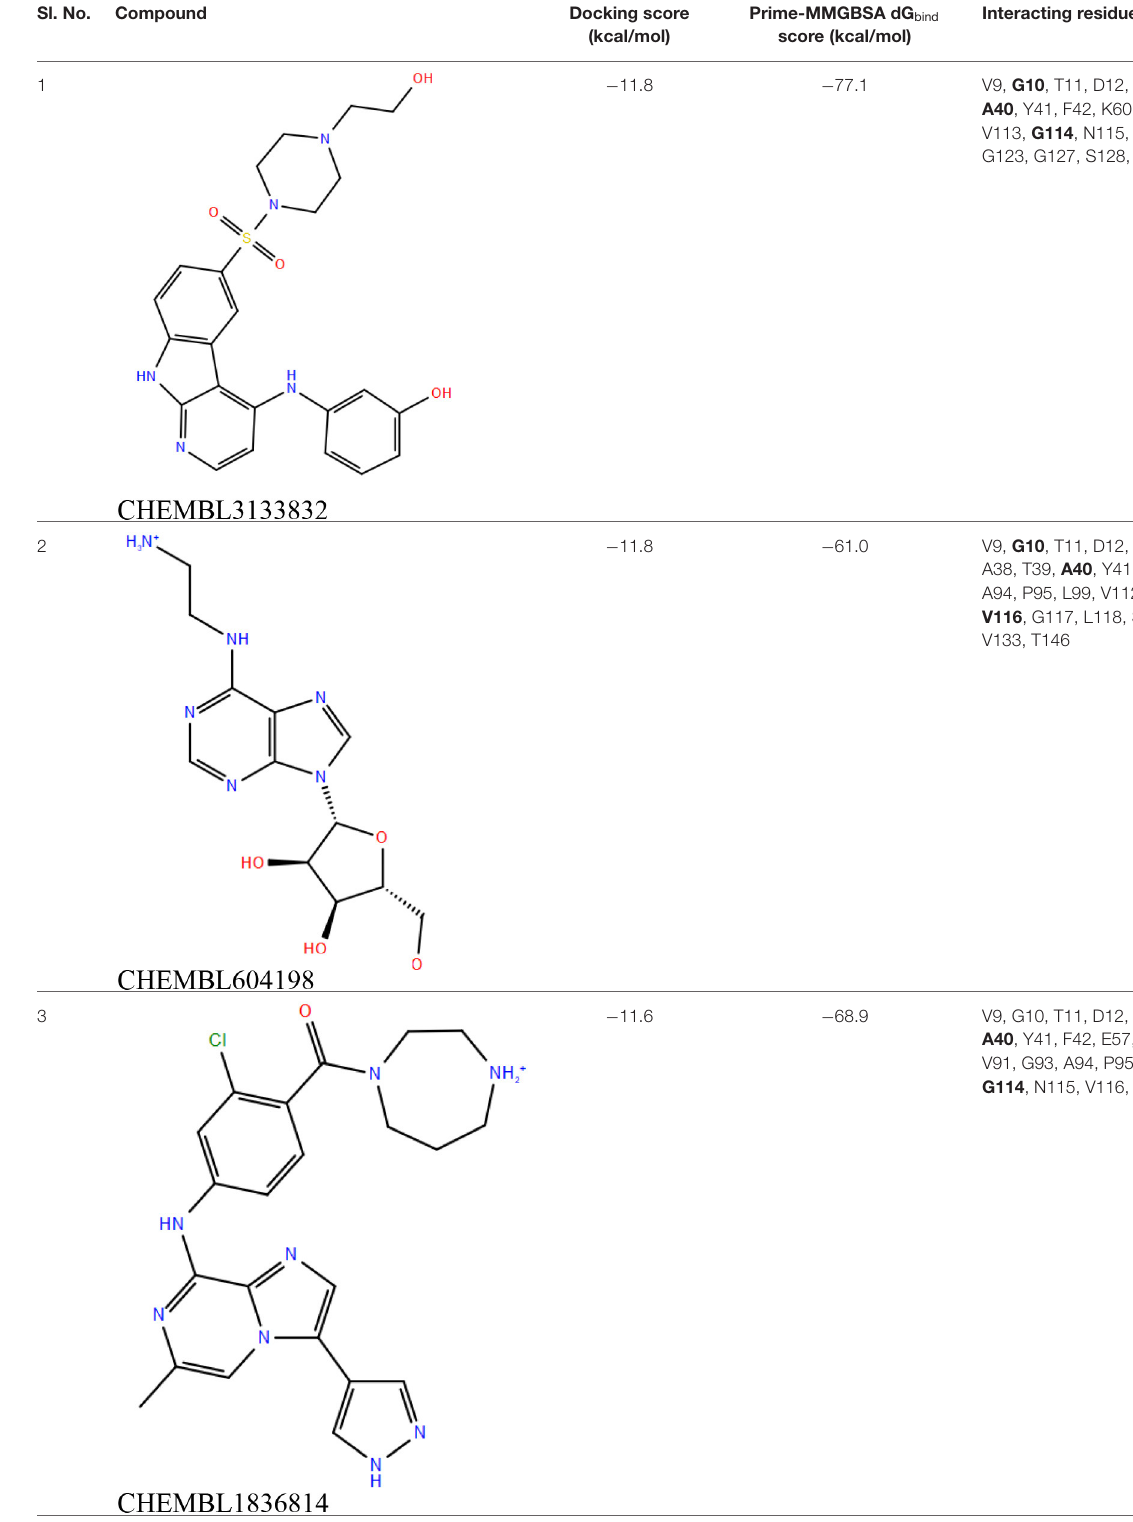
TABLE 1 | Results of molecular docking and Prime-MMGBSA calculation of 22 shortlisted candidates. Sl. No.